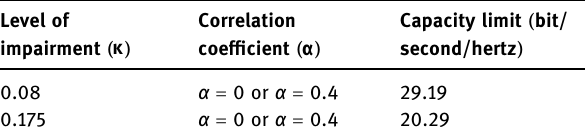
Table 1: Capacity limit values of the 4 4 × MIMO channel with dif